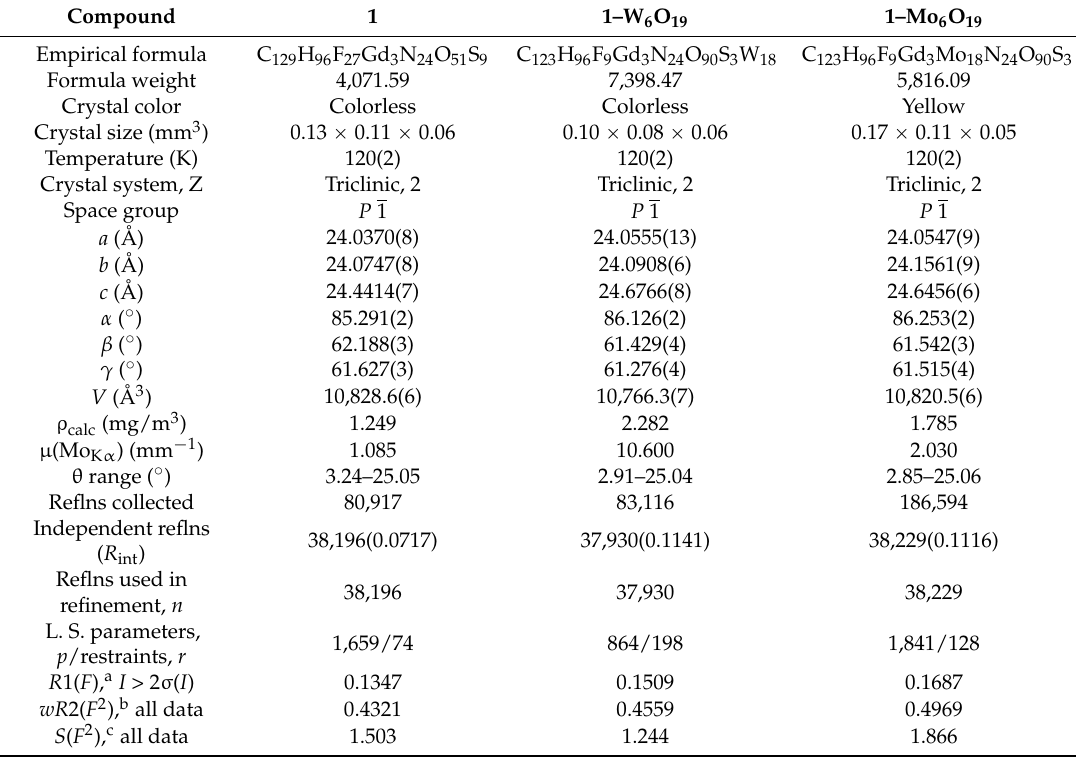
Table 1. Crystallographic data for compounds 1 , 1–W 6 O 19 and 1–Mo 6 O 19